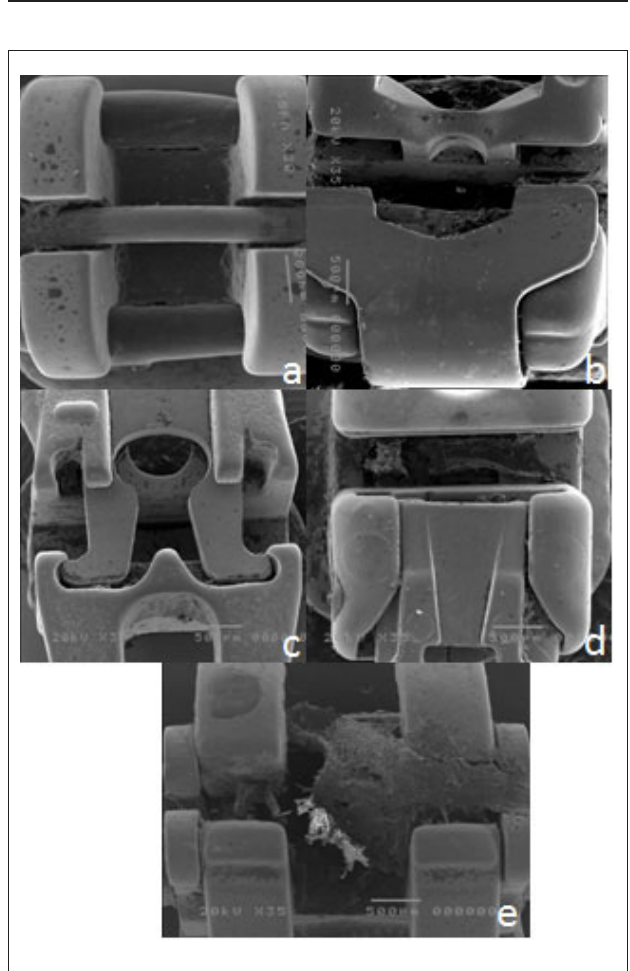
Fig. 3. SEM micrograph of brackets with adhered microorganism (35x magnification); a) conventional; b) GAC; c) Aditek; d) Ormco and e)